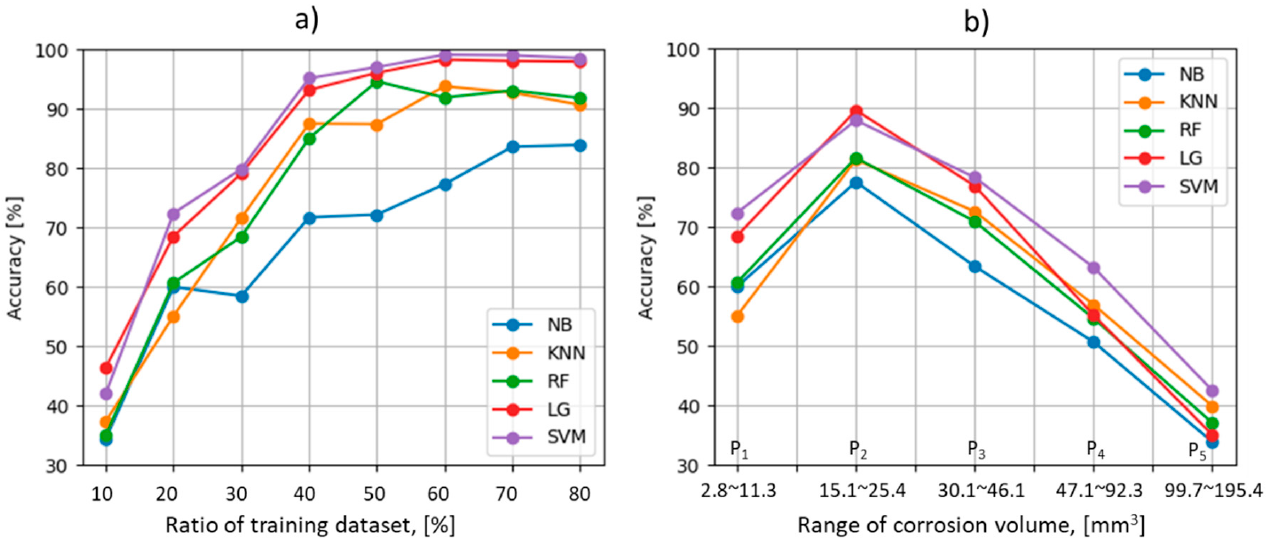
Figure 11. Validation accuracy of different machine-learning models with: ( a ) a different number of training datasets (ratio with entire dataset) in “increasing” dataset and ( b ) fixed 20% ratio at different corrosion volume ranges in “shifting” dataset.